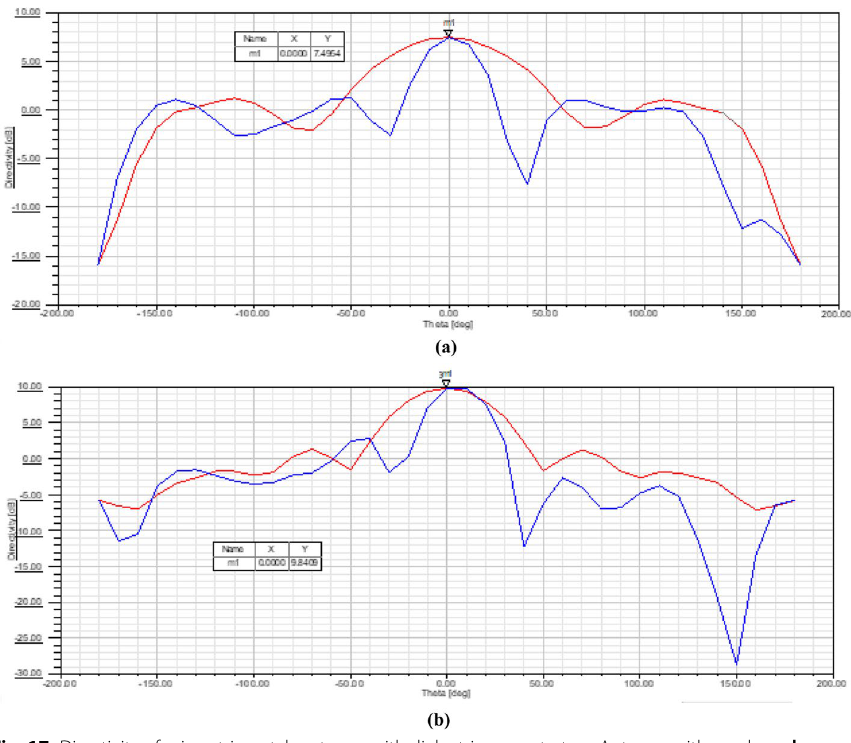
Fig. 17 Directivity of microstrip patch antenna with dielectric superstrate. a Antenna with one layer. b Antenna with two layers